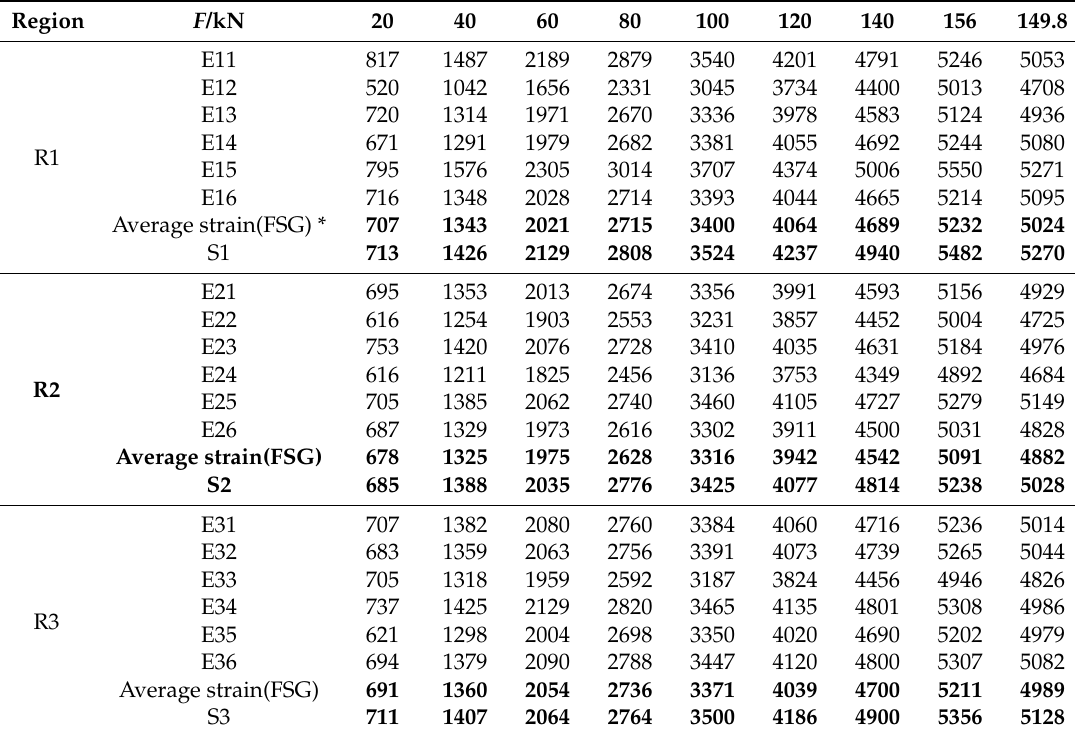
Table 1. The monitored strains of the strand at Step I. (Unit: µε ).